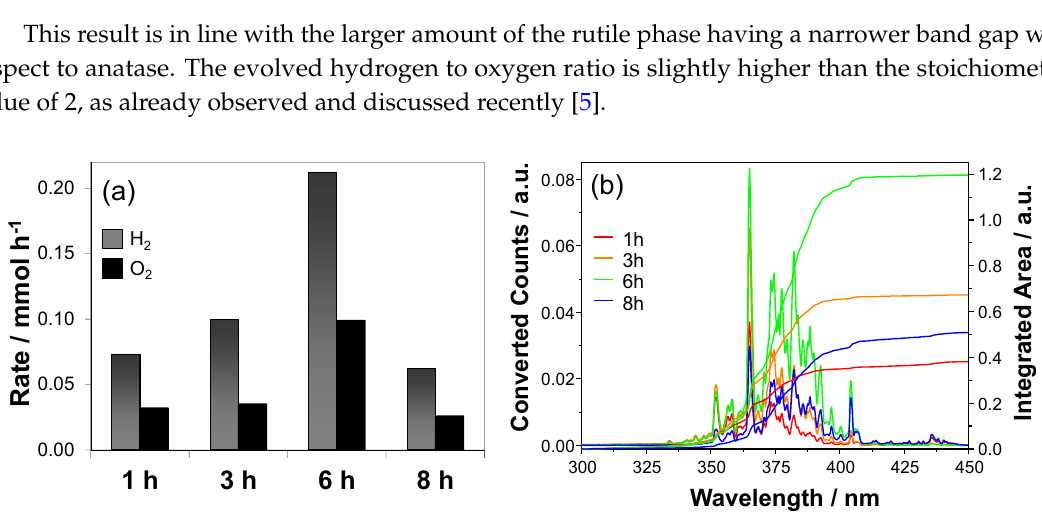
Figure 6. ( a ) Rate of hydrogen and oxygen production under polychromatic light irradiation obtained with the photoelectrodes obtained with different deposition times; ( b ) expected portion of converted incident spectrum and corresponding integrated area (calculated as the product of the IPCE curves times the emission spectrum of the light source).